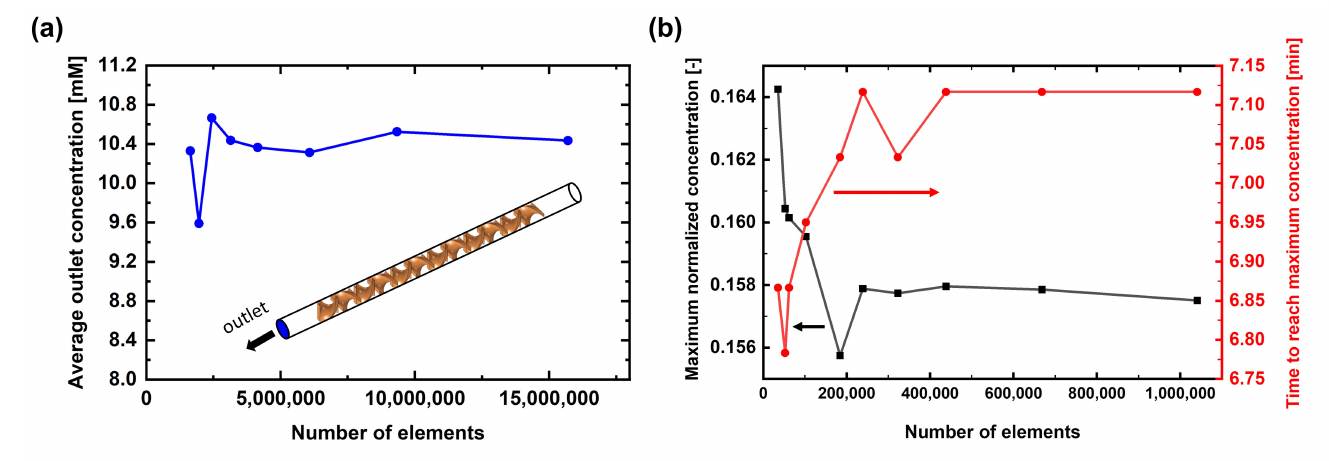
Figure 3. Mesh convergence test results for the CFD simulations of ( a ) the static mixer and ( b ) the filter